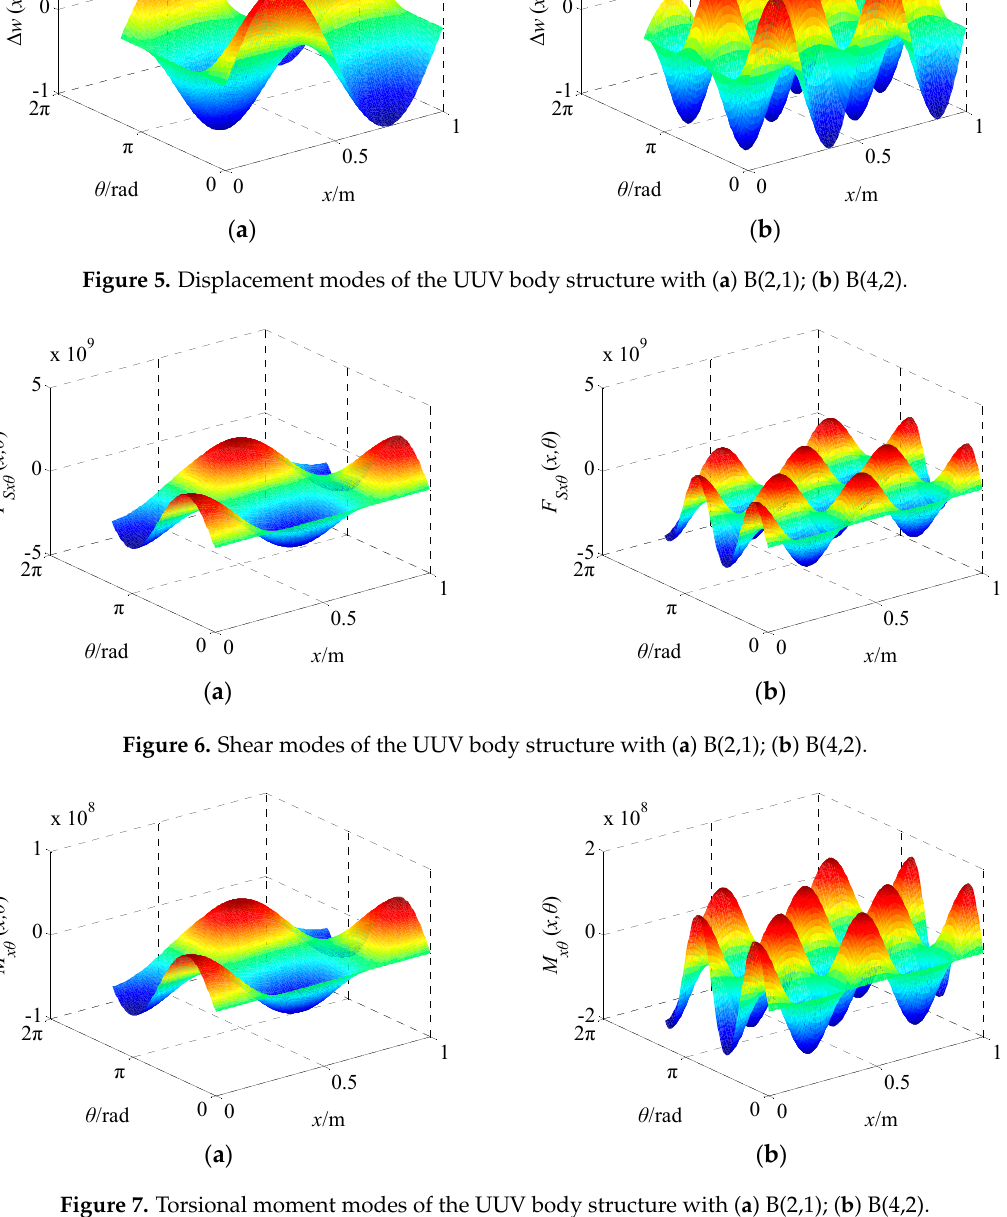
Figure 7. Torsional moment modes of the UUV body structure with ( a ) B(2,1); ( b ) B(4,2).